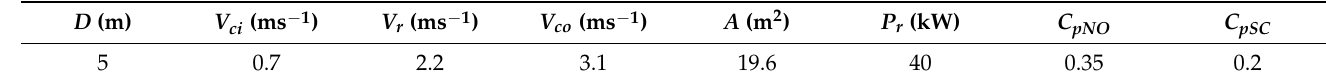
Table 3. Technical specifications of the Evopod turbine as provided by its developer (rotor diameter ( D ) , cut-in velocity ( V ci ), rated velocity ( V r ), cut-of velocity ( V co ), swept area ( A ), rated power (P r ) , power coefficient in normal operation ( C pNO ), and power coefficient in stall control ( C pSC )).